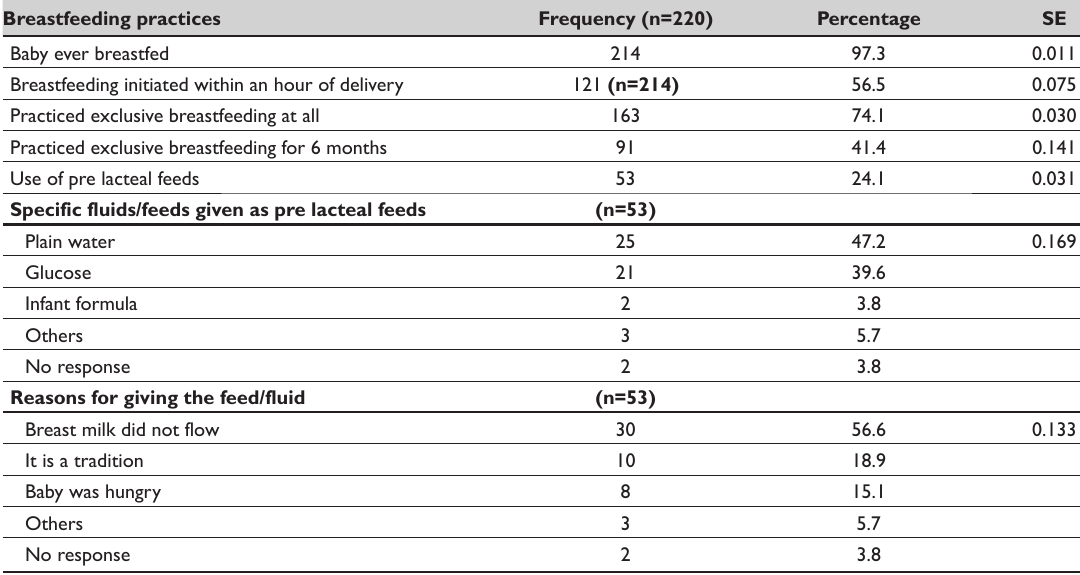
Table 3: Breastfeeding practices of the mothers in the study Breastfeeding